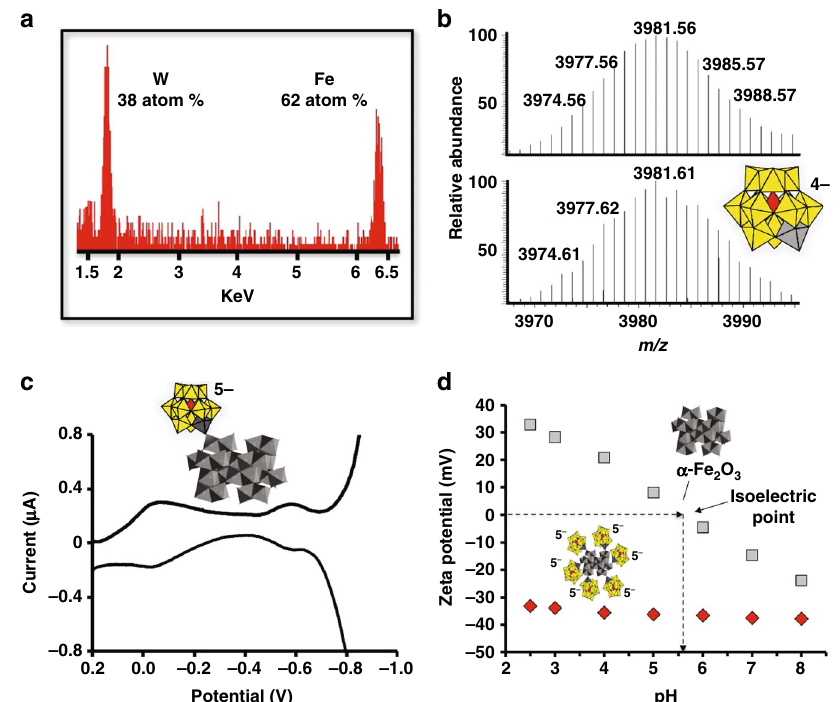
Fig. 2 Characterization of cluster-anion ligands on the hematite cores of 1. a EDX spectrum of 1 . b Top: ESI-MS spectrum; bottom: a simulated spectrum, showing a precise match with the Keggin ion [(TBA) 5 {PW 11 O 39 Fe III (H 2 O) 2 }] + (see Supplementary Figure 14). Inset: the Keggin anion, with the Fe(III)- centered polyhedron in gray. (In water, the outward-facing coordination site on Fe(III) is occupied by H 2 O or OH – , or by a μ 2 – O 2 – linkage to Fe(III) in a second cluster anion.). c Differential pulse voltammogram (DPV) of 1 in 100 mM LiClO 4 and acetate buffer (pH 3.3). Two reversible redox waves (at − 50 mV and − 590 mV) correspond to the Fe(III/II) redox couple, and to 1-e – reduction of W(VI) in [ α -PW 11 O 39 Fe] 4 – on the surface of the hematite cores. The second (more negative) redox couple of the W(VI) atoms is not well resolved due to overlap with a large cathodic current at − 700 mV (possibly due to H 2 formation, and/or to reduction of Fe(III) in the hematite cores). (See Supplementary Figure 15b for comparison to [( α -PW 11 O 39 Fe III ) 2 O] 10 – ( 2. )) d The surface zeta potentials ( ζ , in units of mV) of colloidal α -Fe 2 O 3 (suspension; gray squares) are positive at low pH values and negative at pH values above the isoelectric point near pH 5.5, as indicated by the dotted lines. By contrast, 1 (red diamonds) is soluble and negatively charged from pH 2.5 to 8. (Atomic connectivity of the cluster-anion ligands to the hematite surface is discussed